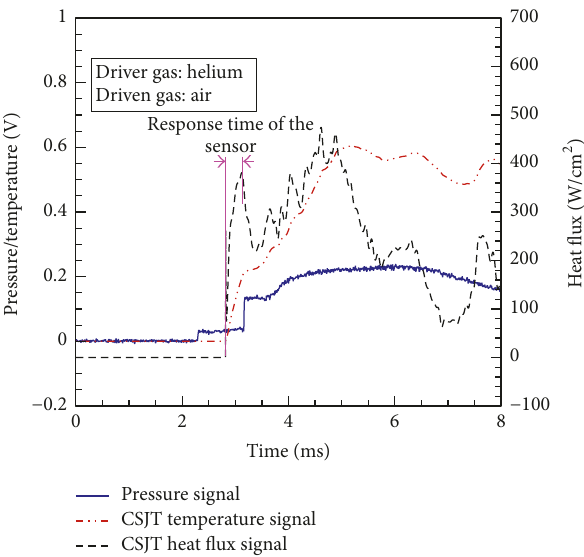
Figure 14: Temperature and heat flux variation for the spherical test model in shock tube